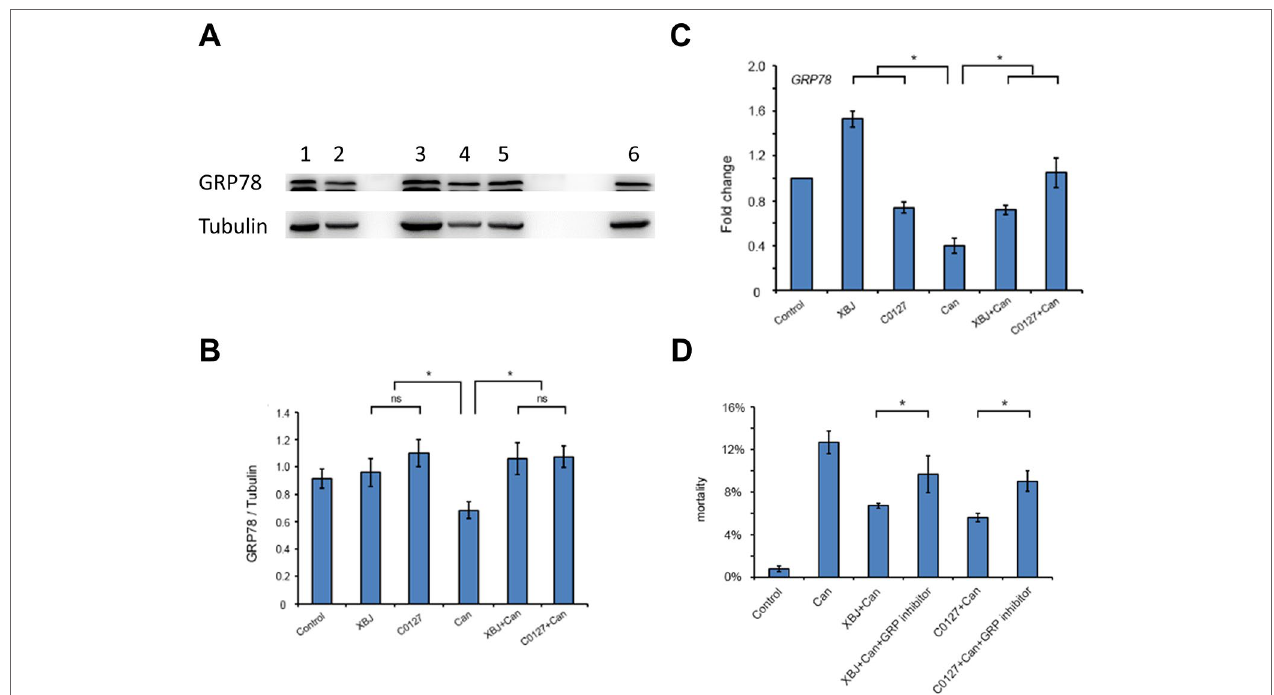
FIGURE 8 | XBJ and C0127 sustained GRP78 expression to improve the survival of 293T cells. (a) C0127 maintained GRP78 expression on protein level in 293T cells upon C. albicans infection. Western blot experiments were conducted to determine the expression of GRP78. Tubulin was used as an internal control. Lane 1. Control 293T cells; lane 2. C . Albicans infected 293T cells; lane 3. XBJ treated 293T cells; lane 4. C . albicans infected 293T cells treated with C0127; lane 5. C . albicans infected 293T cells treated with XBJ; lane 6. C0127 treated 293T cells. (B) Quantification of the GRP78 protein in 293T cells upon different treatments. Data were representative of at least three independent experiments with similar results. (C) Real-time PCR to determine the mRNA expression of GRP78 in 293T cells upon different treatments. (D) The influence of HA15, a GRP78 inhibitor, on the survival of 293T cells in low serum culture under different conditions by PI staining. Data were representative of at least three independent experiments with similar results. *P <